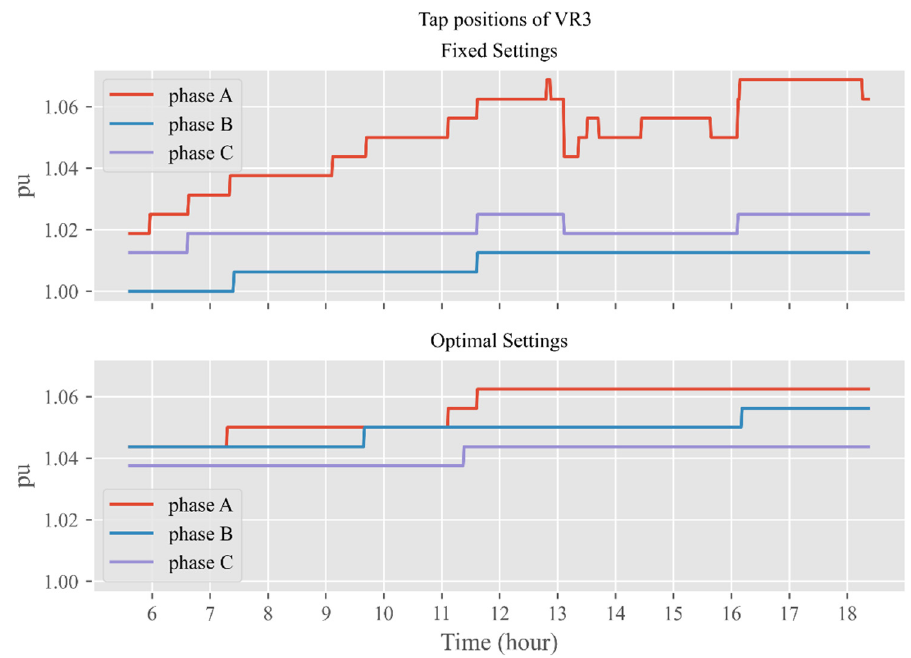
Figure 15. Three-phase tap positions of VR3.